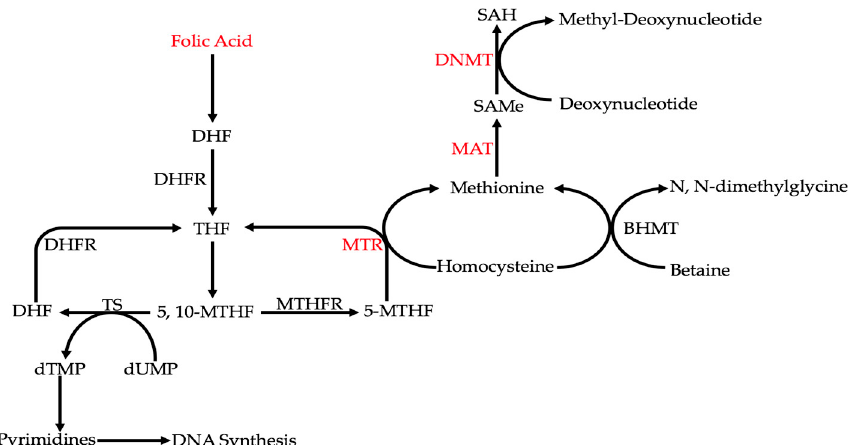
Figure 2. Ethanol indirectly interferes with DNA integrity by affecting key points (labeled in red) or enzymes in folate metabolism. From these key points, DNA synthesis and methylation are hindered. A reduction in folic acid levels decreases all reactions in the above pathway. Reducing methionine synthase (MTR) activity inhibits both DNA synthesis and DNA methylation. Reducing methionine synthase (MAT) and DNA methyltransferase (DNMT) activities inhibits DNA methylation.